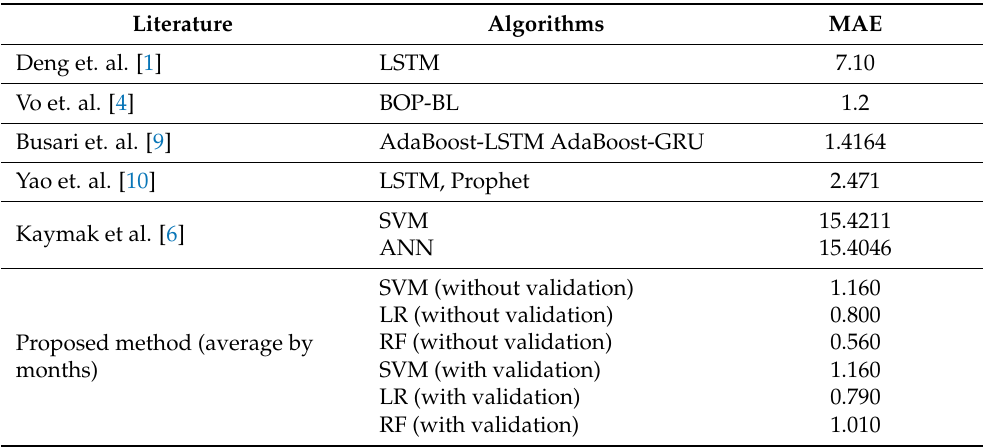
Table 5. Performance comparation with the